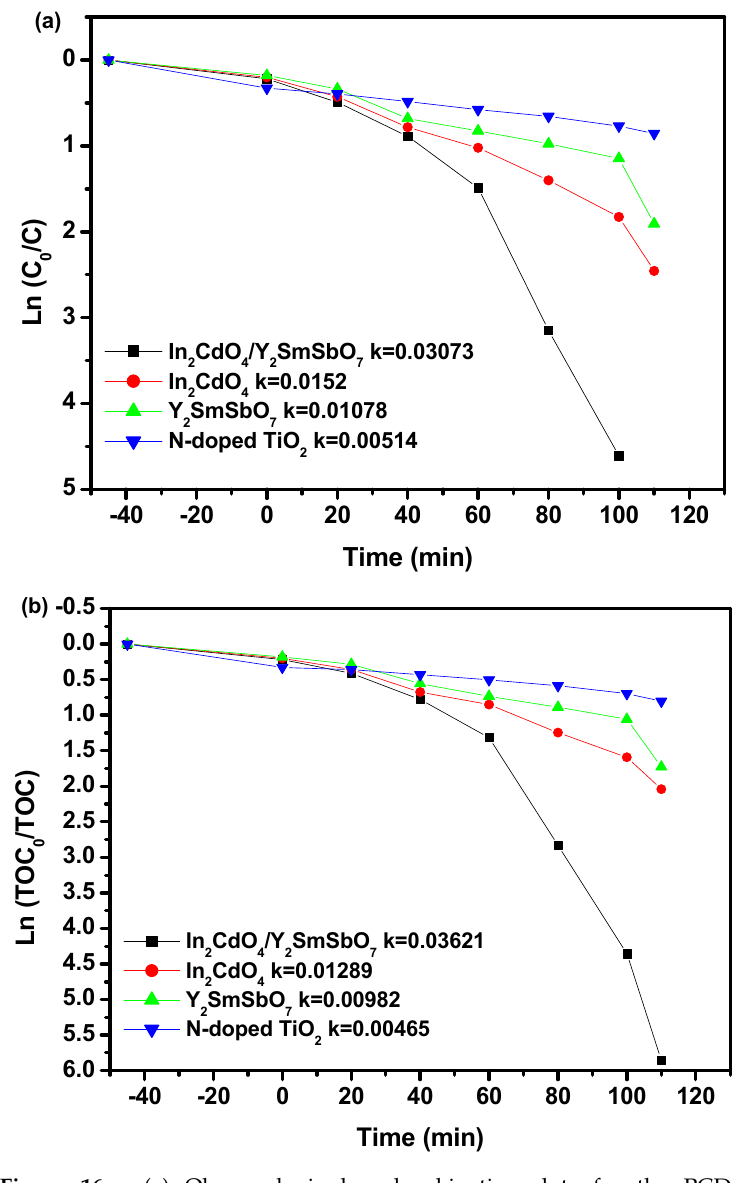
Figure 16. ( a ) Observed single-order kinetics plots for the PCD of rhodamine B with In 2 CdO 4 /Y 2 SmSbO 7 nanocomposite, In 2 CdO 4 , Y 2 SmSbO 7 , or N-TO as the photocatalyzer under VLI. ( b ) Observed single-order kinetic plots for TOC during PCD of rhodamine B in dye wastewater with In 2 CdO 4 /Y 2 SmSbO 7 nanocomposite, In 2 CdO 4 , Y 2 SmSbO 7 , or N-TO as the photocatalyzer under visible light irradiation.